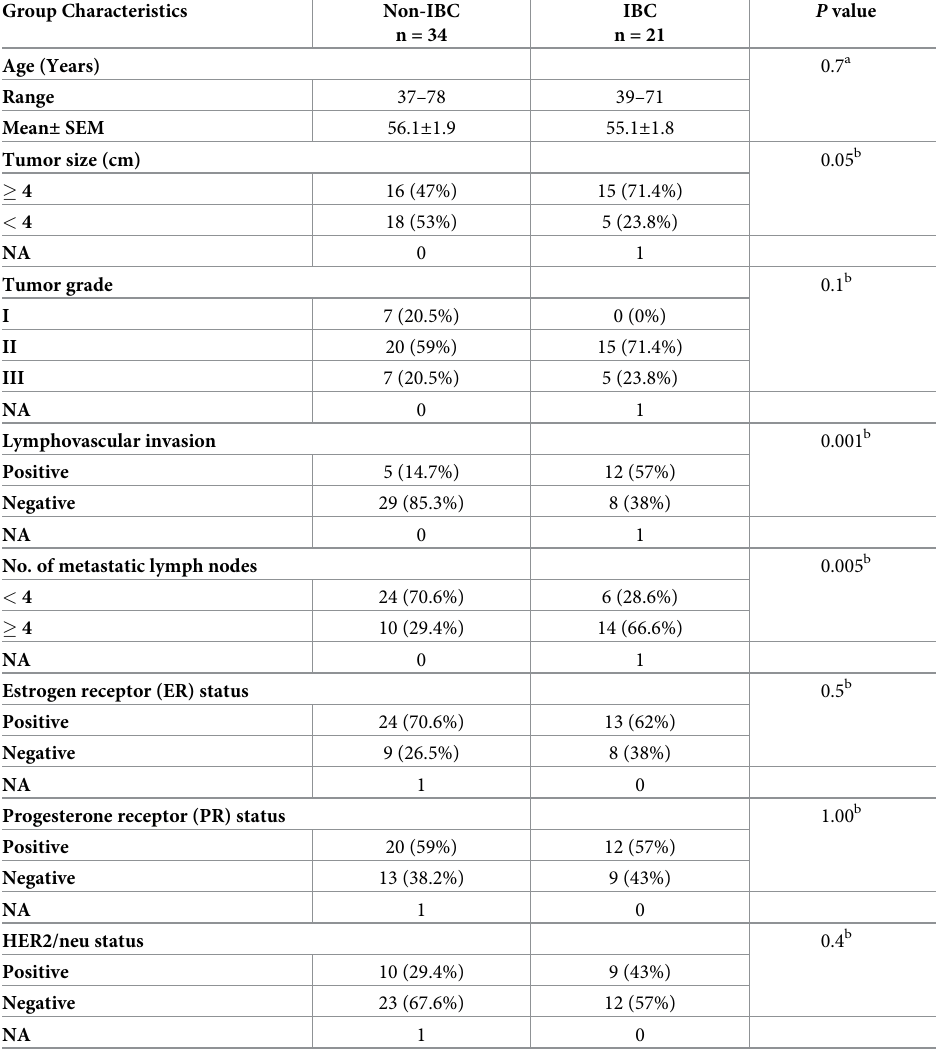
n = number of patients, NA = not available data